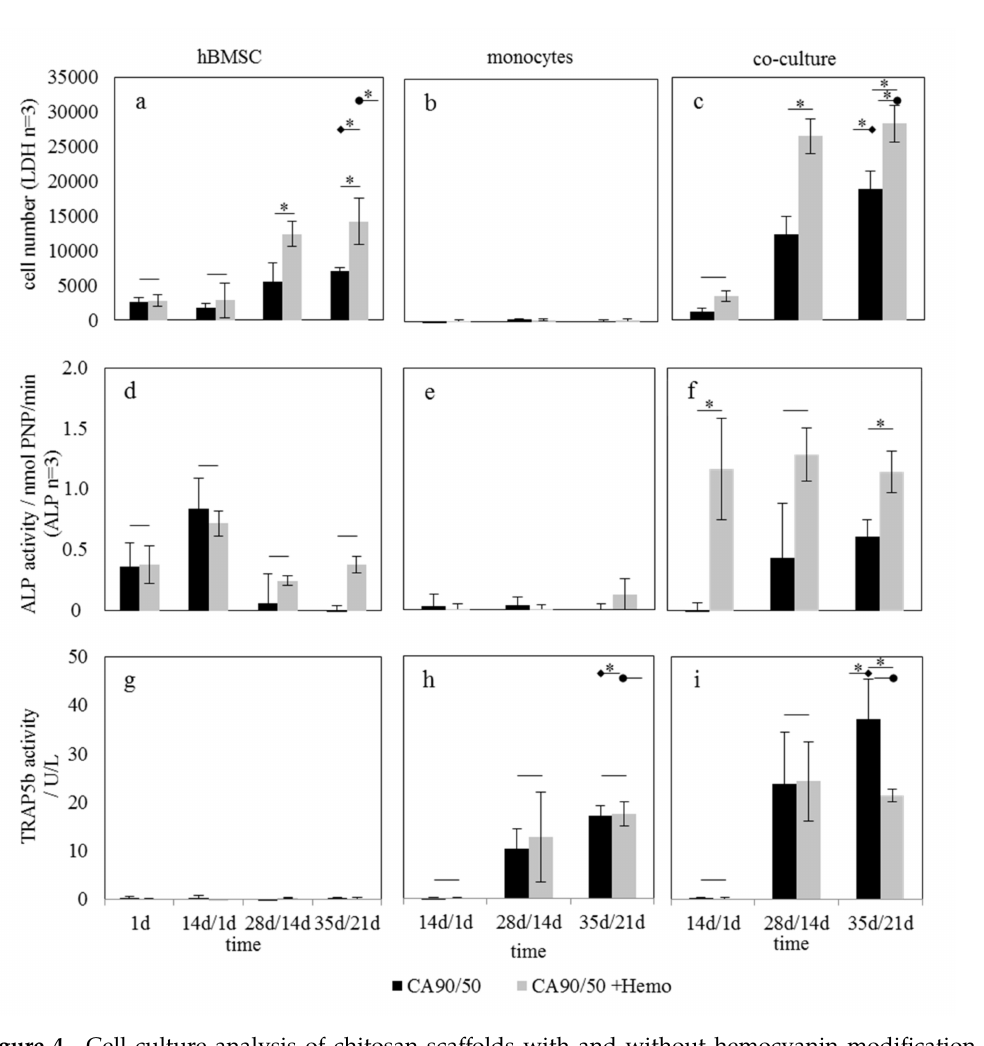
Figure 4. Cell culture analysis of chitosan sca ff olds with and without hemocyanin modification. Adhesion and proliferation data are presented in terms of cell numbers (LDH) in ( a ) hBMSC mono-culture, ( b ) hM mono-culture, and ( c ) co-culture. Osteogenic di ff erentiation of these cells was analyzed in terms of ALP activity ( d – f ), while osteoclastic ripening was measured in terms of TRAP5b activity ( g – i ). The arrow tails in ( a , c ) as well as those in ( h , i ) show the result of significance analysis for selected candidate pairs of values. An asterisk is placed on both arrow tails to indicate significant di ff erence with a p value of <